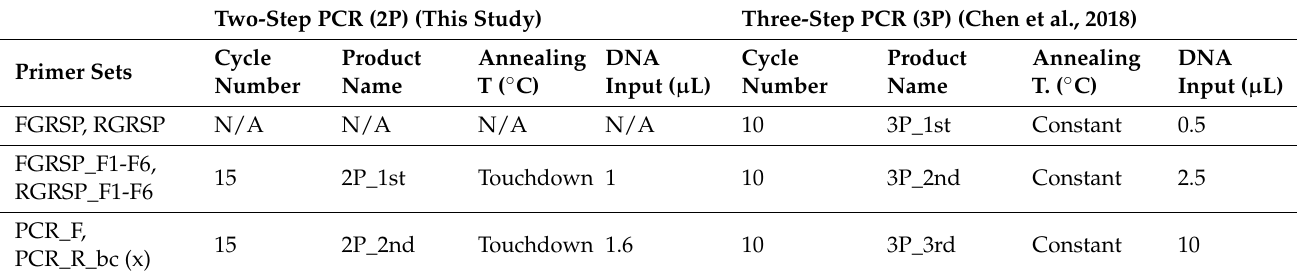
Table 2. PCR program differences between two-step PCR (2P) and three-step PCR (3P) protocols, including cycle number, annealing approach, and template